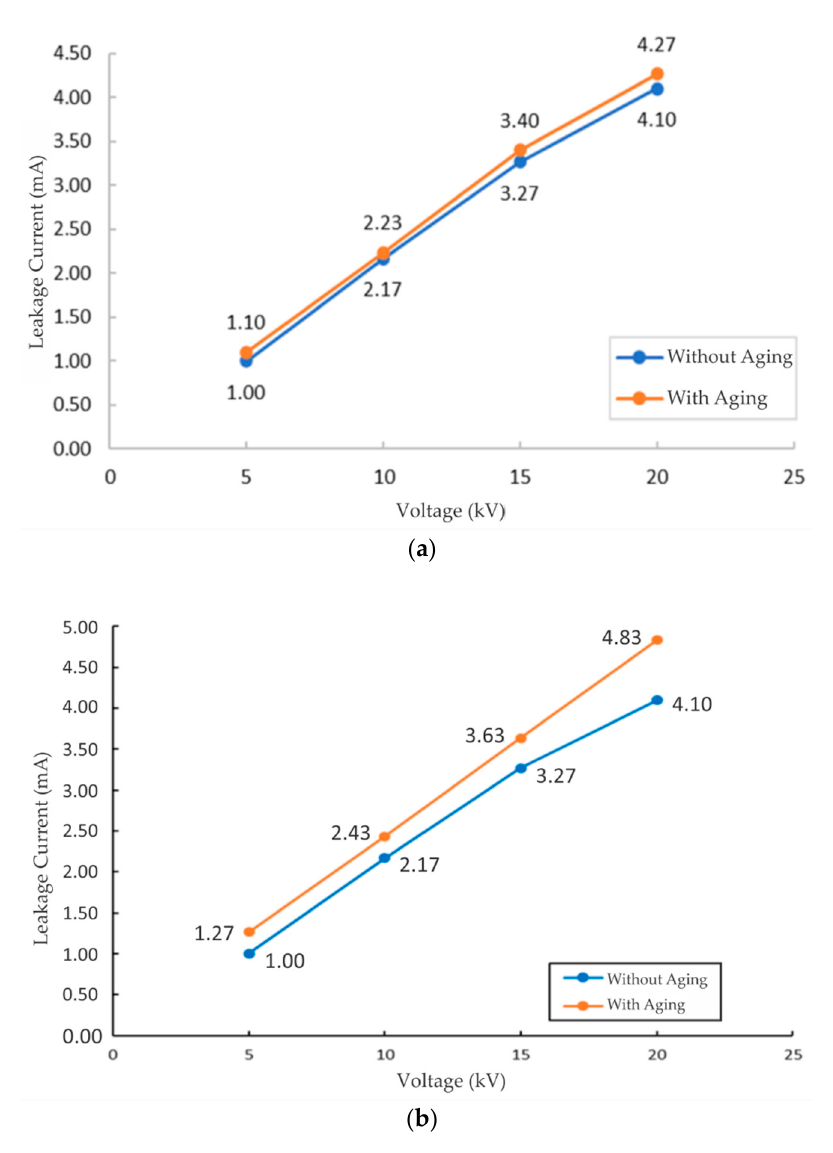
Figure 17. Comparison of leakage current in unaged insulators and insulators with aging ( a ) salt contaminants and ( b ) fly ash contaminants.